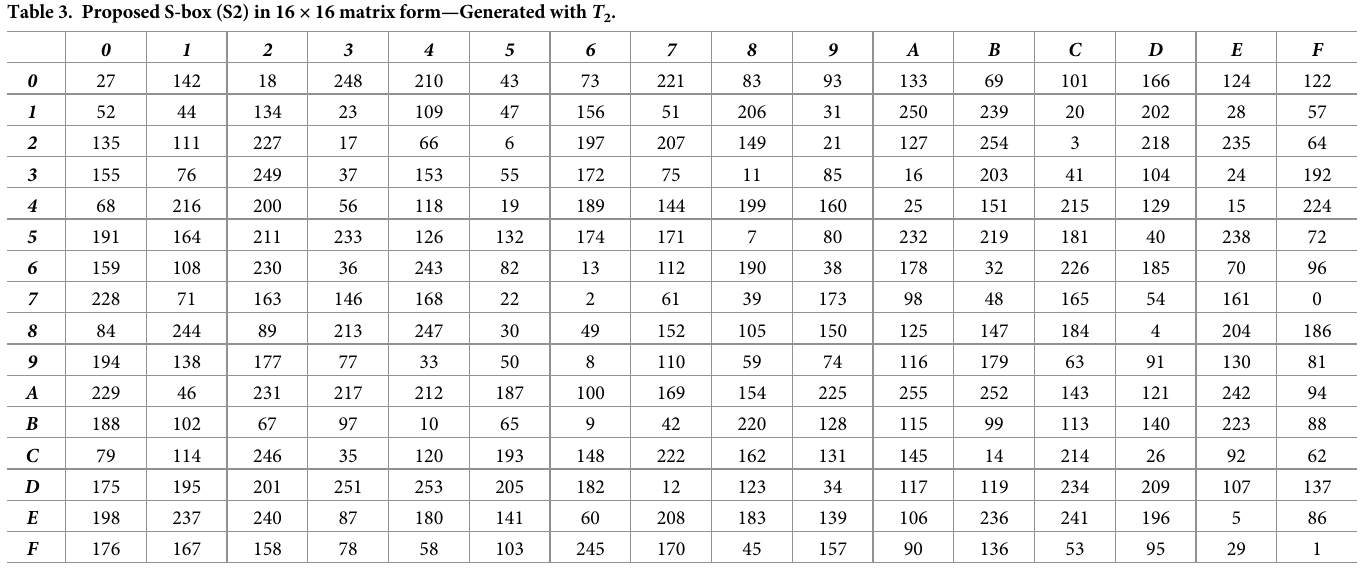
Table 3. Proposed S-box (S2) in 16 × 16 matrix form—Generated with T 2